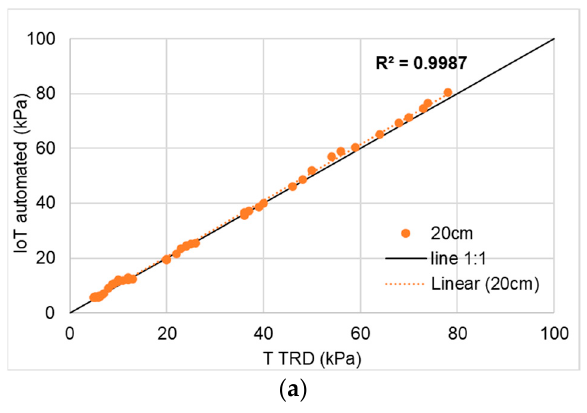
Figure 5. Online soil water potential curve from ThingSpeak.